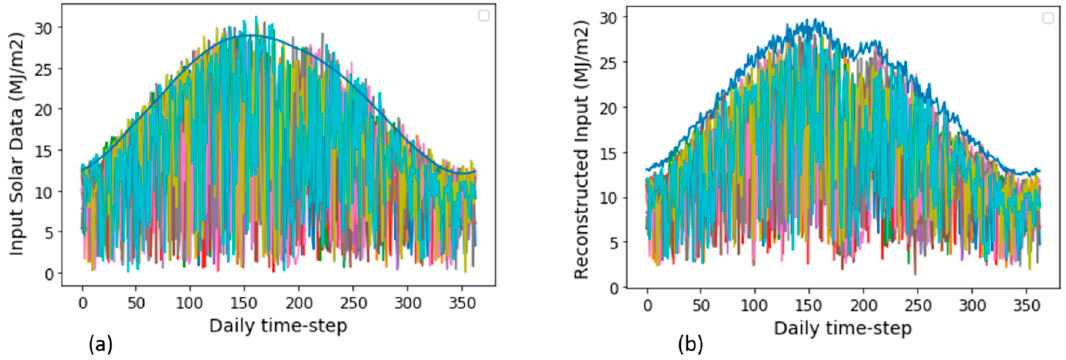
Figure 8. AE training. ( a ) Actual input and ( b ) reconstructed input. Table 1. Optimal parameter settings to train the AE model